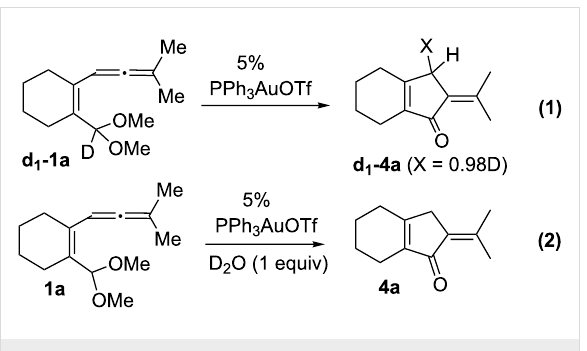
Scheme 2: Gold-catalyzed cyclization of deuterated d 1 -1a